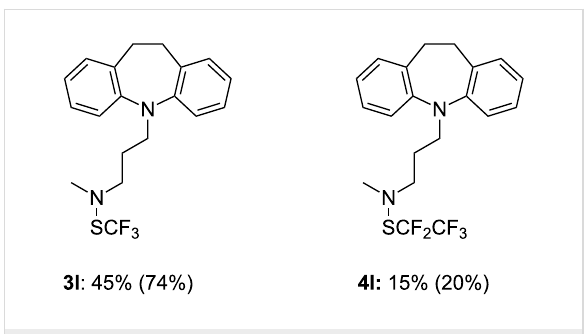
Figure 3: Synthesis of fluoroalkylthio analogs of imipramine. (Isolated yields, in parentheses crude yields determined by 19 F NMR with PhOCF 3 as an internal